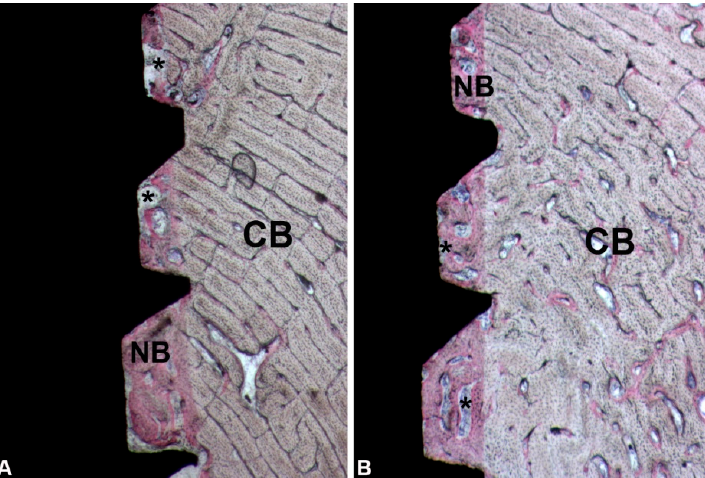
Figure 7. Cortical portion. New bone (NB) as well as small marrow spaces (*) between implant surface and cortical bone (CB) was observed in control ( A ) and in test ( B ) groups. (Acid fuchsin-Toluidine blue 18X) .